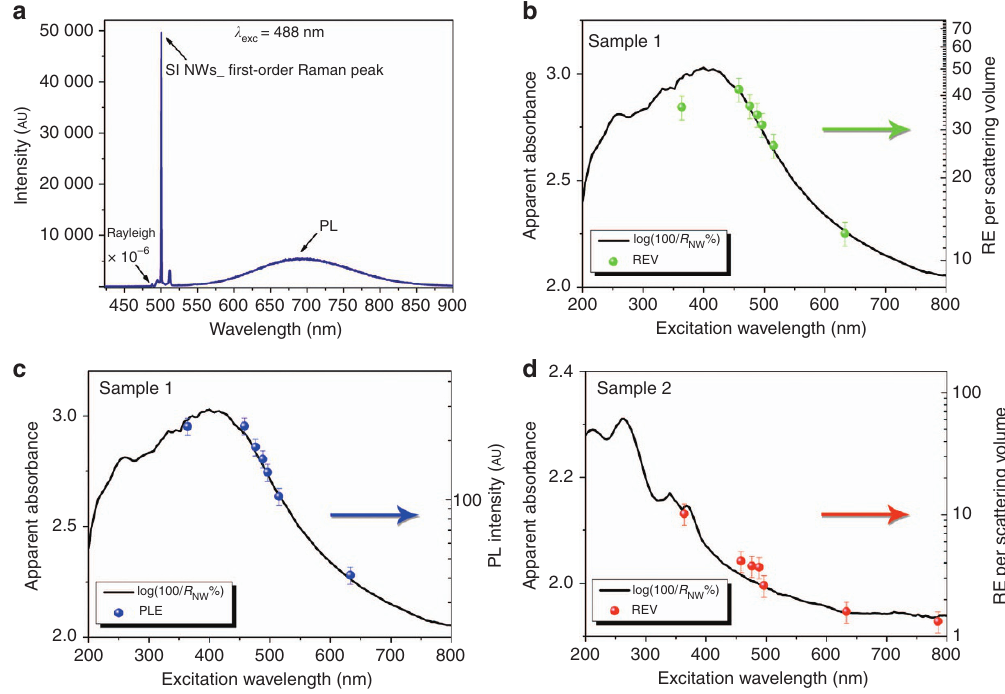
Figure 4 Photoluminescence emission and Raman scattering from the Si NW fractal array. ( a ) Raman backscattered radiation and PL emission from the Si NW sample 1 at an incident laser wavelength of 488 nm (power 20 mW on a spot with a 100 μ m diameter). ( b ) Raman enhancement of Si NW sample 1 with respect to the c -Si bare substrate. ( c ) PLE of sample 1 evaluated at 690 nm. ( d ) Raman enhancement of Si NW sample 2 with respect to the c -Si bare substrate. All the trends are plotted as a function of the incident laser wavelength and compared to the apparent absorbance of the corresponding sample (black lines). The arrows indicate the y -axis corresponding to the plotted data having the same